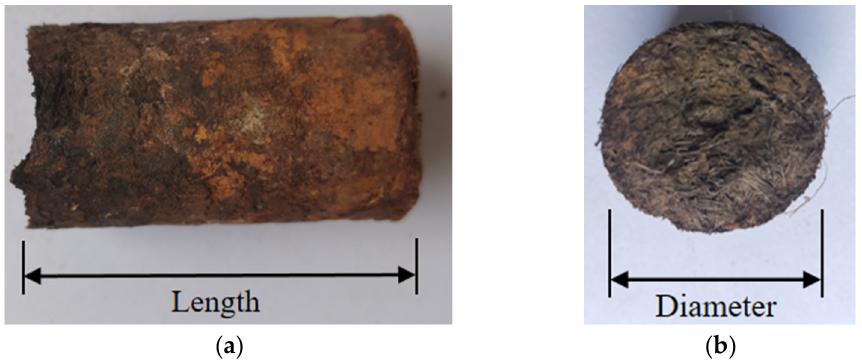
Figure 4. Size of the briquette: ( a ) Length of the briquette; ( b ) Diameter of the